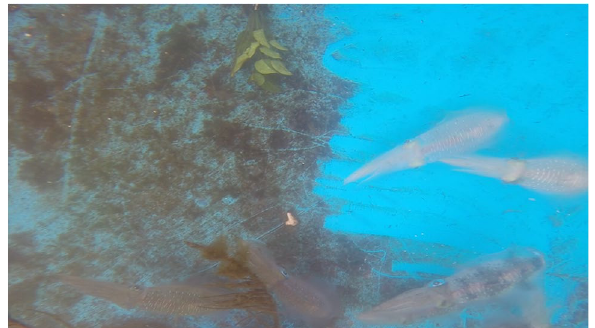
Figure 1. Squid substrate matching. The captive white-squid are swimming above a partially cleaned bottom of their tank, which is brighter than the uncleaned area, with dark and light body patterns over the matching dark and light substrate. This is a single frame from the Supplementary Video S1 of our initial observation in